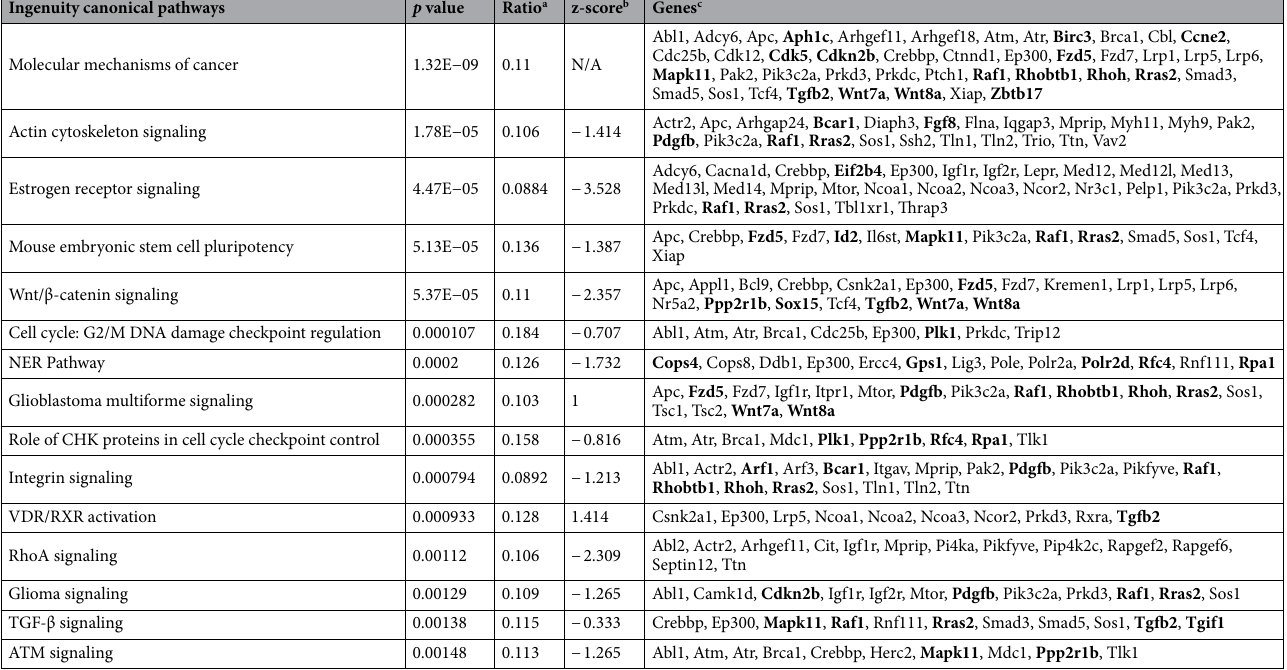
Table 2. Top 15 canonical pathways of differentially expressed genes between secondary follicles with Figla suppression and control. a Ratio of listed genes found in each pathway over the total number of genes in that pathway. b z-score positive when pathways are down-regulated in the Figla siRNA-injected group (=